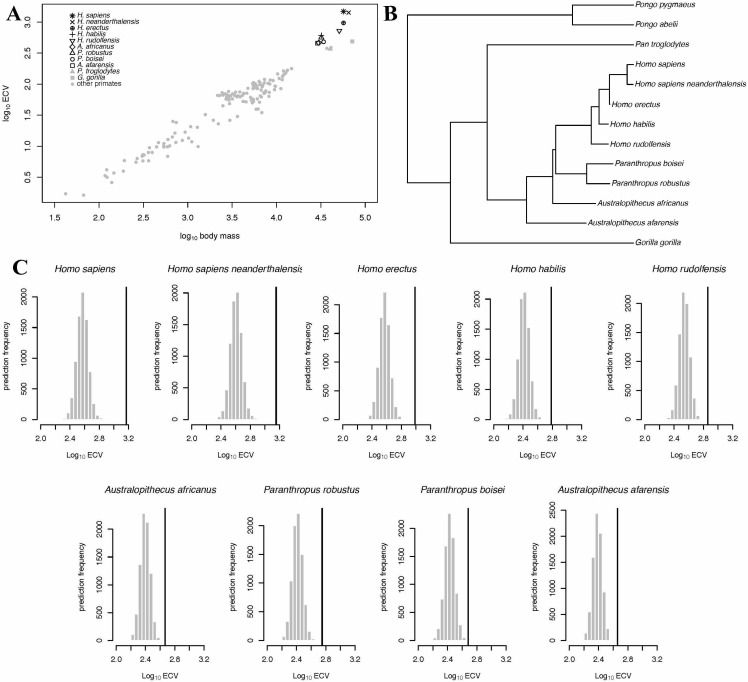
BayesModelS predictions of ECV in hominins.Panel (A) shows a scatter plot of primate ECV and body mass data. Panel (B) shows the topology of the great ape portion of the alternate hominin phylogeny used in the BayesModelS analyses of hominin ECV. Panel (C) shows the posterior distributions of predicted ECV values generated by BayesModelS for hominin species with body mass used as the predictor variable. Vertical lines indicated observed values. The observed value for H. sapiens s exceeded the mean value predicted by BayesModelS by more than seven standard deviations. All hominin species were strongly supported positive outliers, with >99.9% of predictions falling below the observed values for ECV.